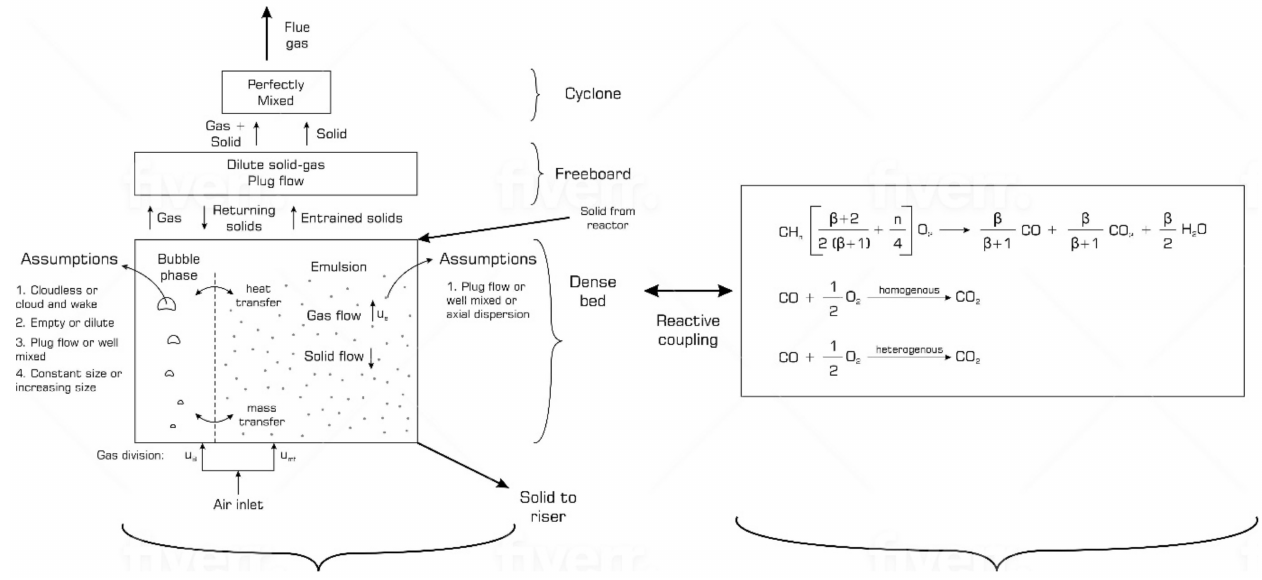
Figure 3. Summary of Regenerator modelling and key hydrodynamic